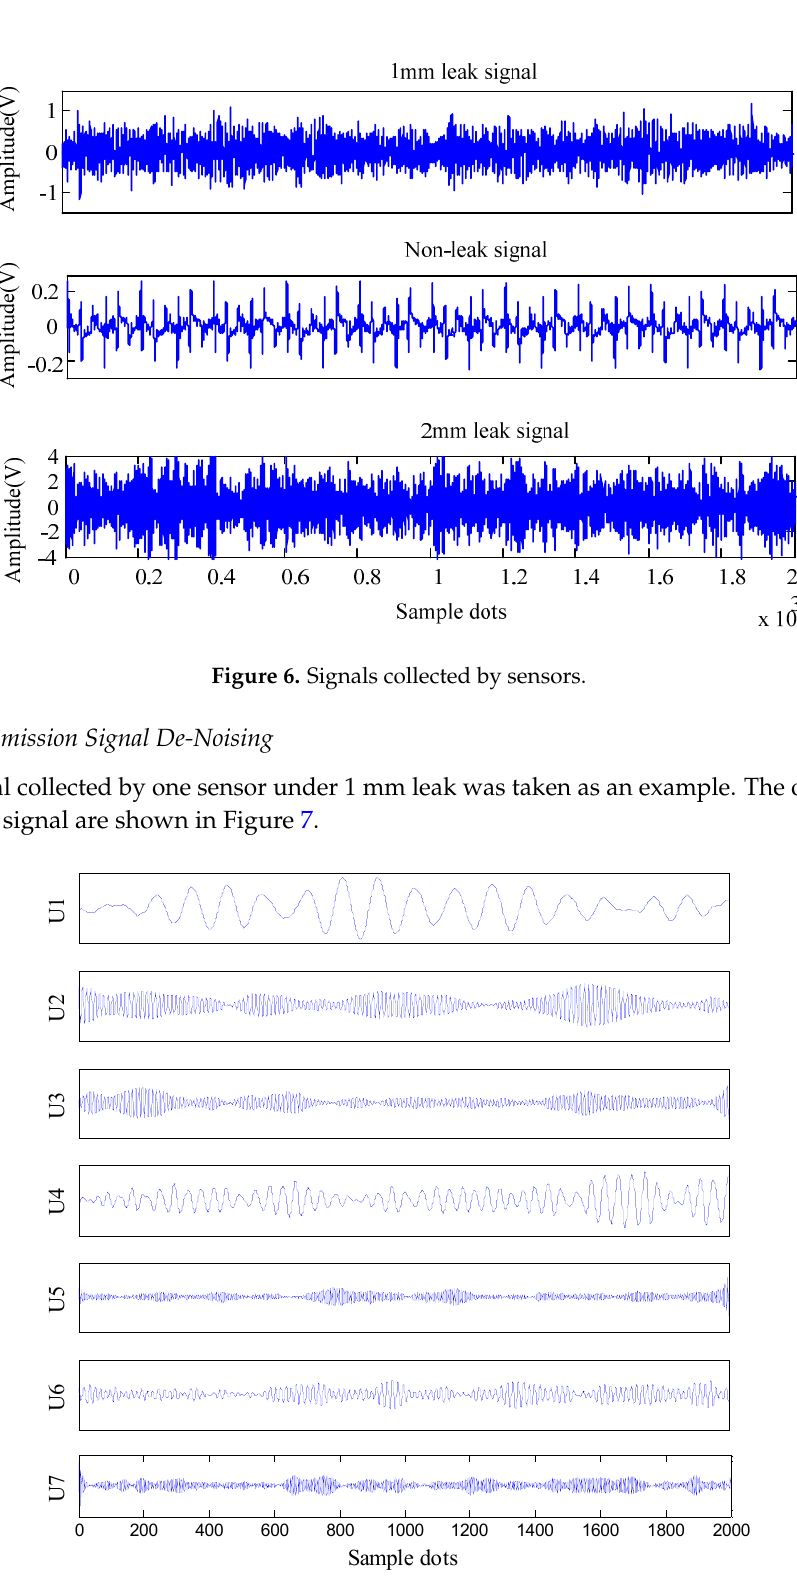
Figure 7. VMD results of a 1 mm leak signal.